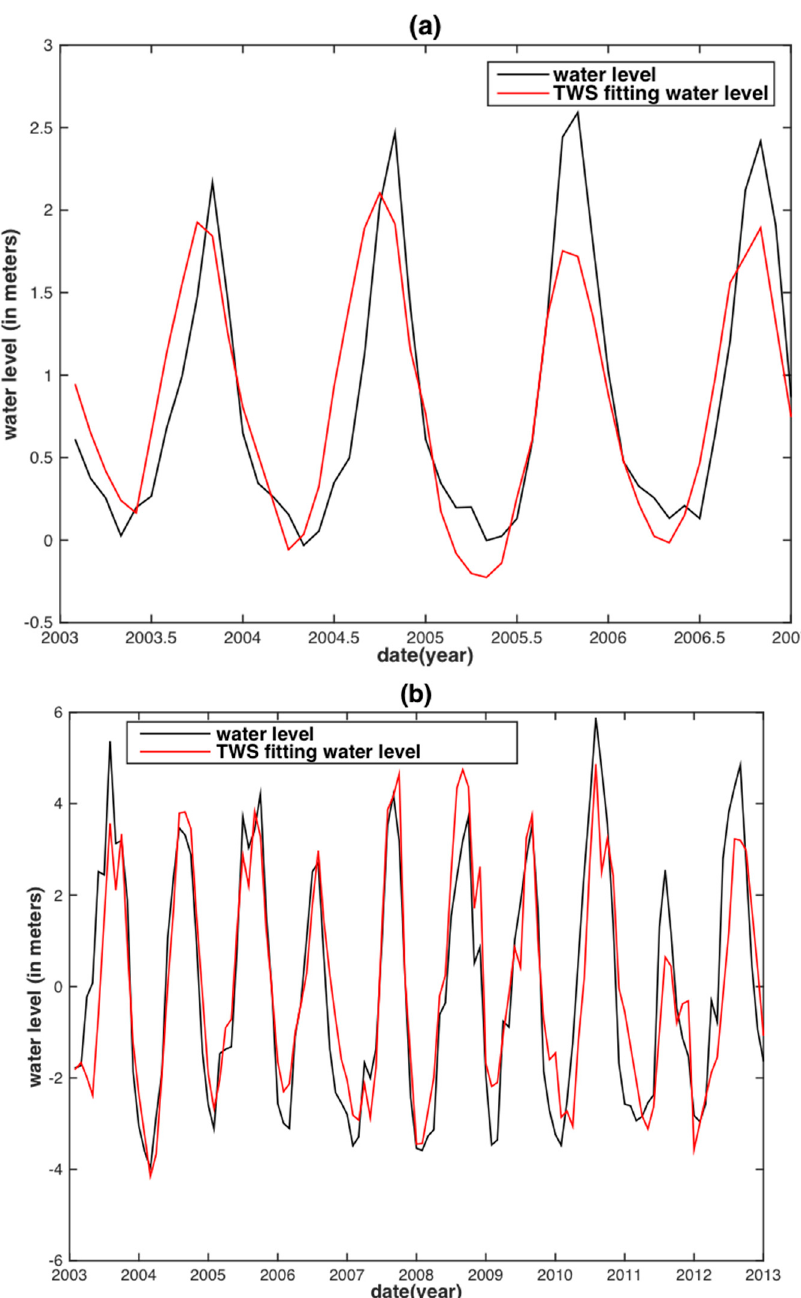
Figure 5. Water level reconstruction from GRACE TWS at Vam Kenh station of the MRB ( a ) and at Datong station of the YRB ( b ).